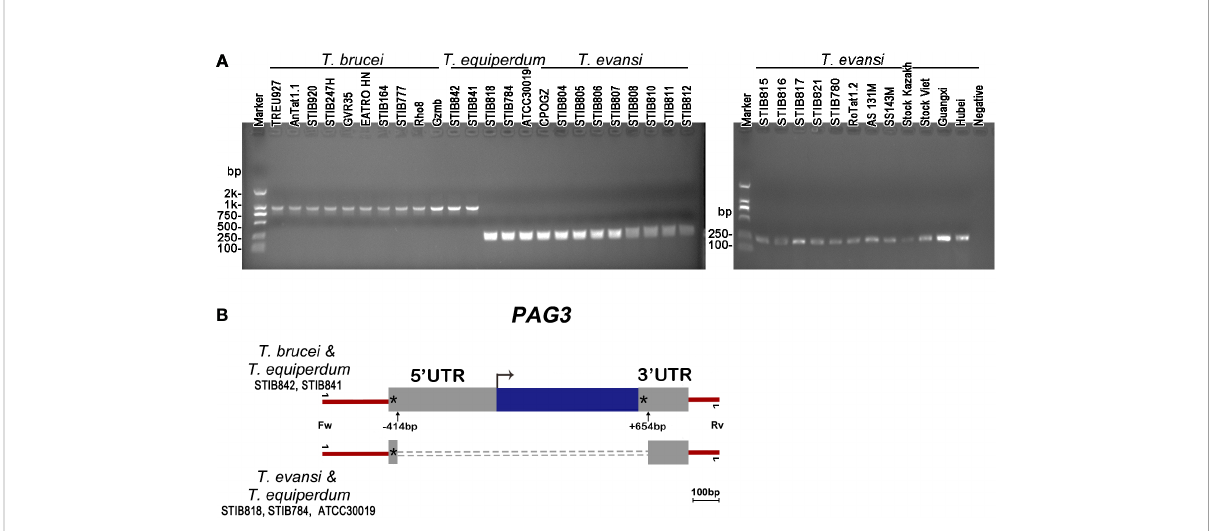
FIGURE 2 PAG3 genes in Trypanozoon species. (A) Electrophoretograms of PCR ampli fi ed fragments of the PAG3 genes in T. brucei, T. equiperdum and T. evansi. The information of the strains used in the PCR is listed in Table 1. (B) Schematic diagram showing a comparison of the PAG3 gene sequences across T. brucei, T. equiperdum and T. evansi. Blue box, the coding region; Grey boxes, the untranscribed regions; Asterisk, the 8-bp tandem repeat of TGTTTGTT; Dotted line, the absent fragment; Bent arrow, the initiation codon; Up arrow, the start and end positions of the absent fragment. The primers used for PCR is